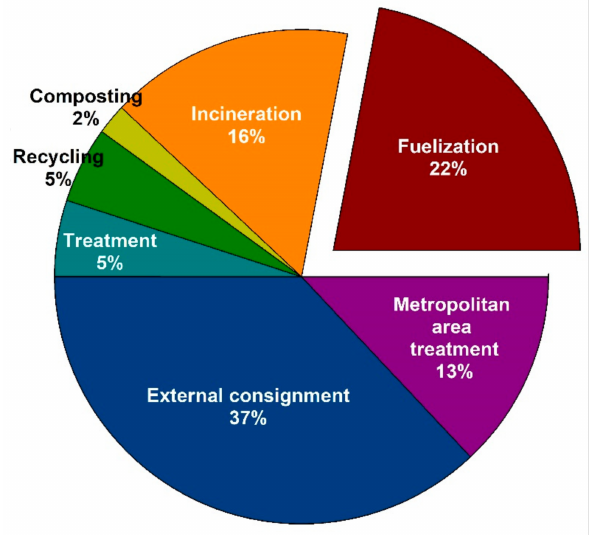
Figure 1. Sewage sludge treatment status in South Korea in 2018